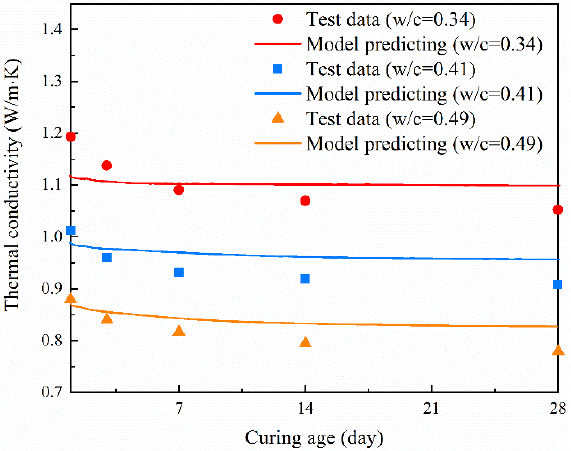
Figure 7. Thermal conductivity of cement pastes: estimations compared to experimental